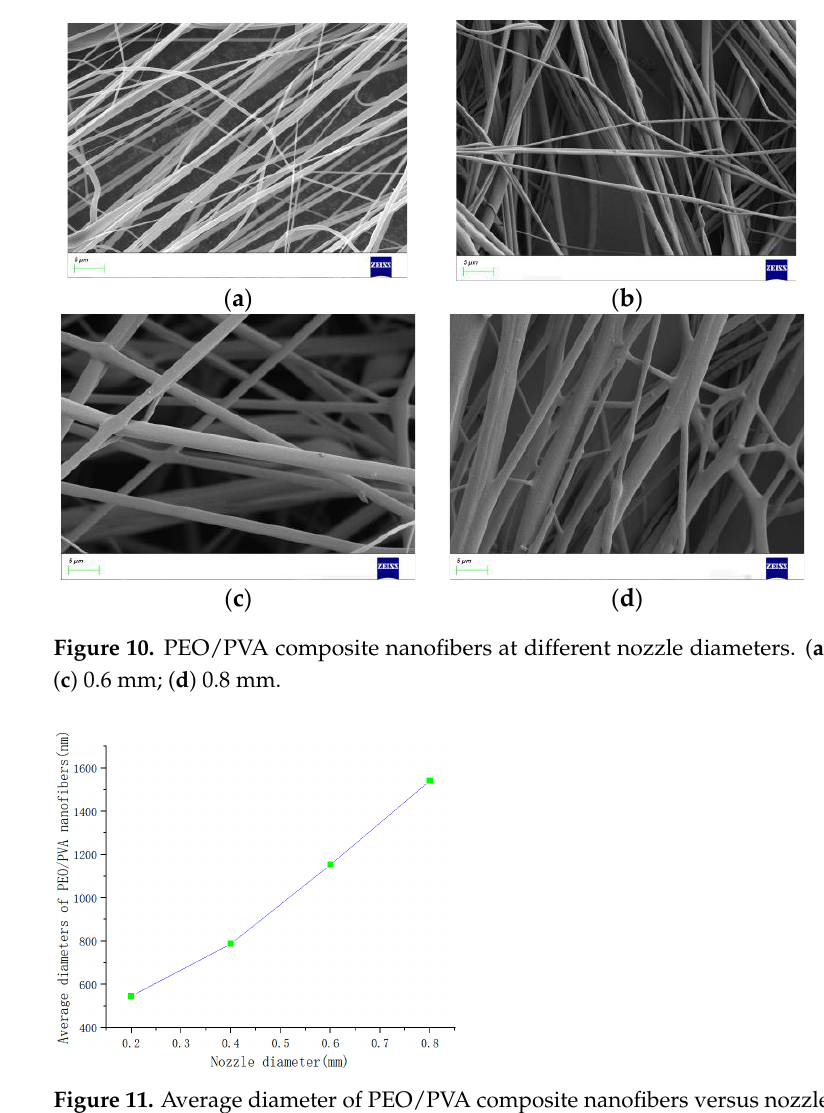
Figure 11. Average diameter of PEO/PVA composite nanofibers versus nozzle diameter.